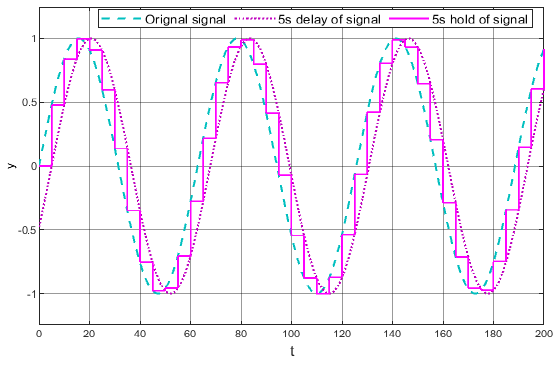
Figure 4. Effect of ZOH. Figure 4. E ff ect of ZOH.